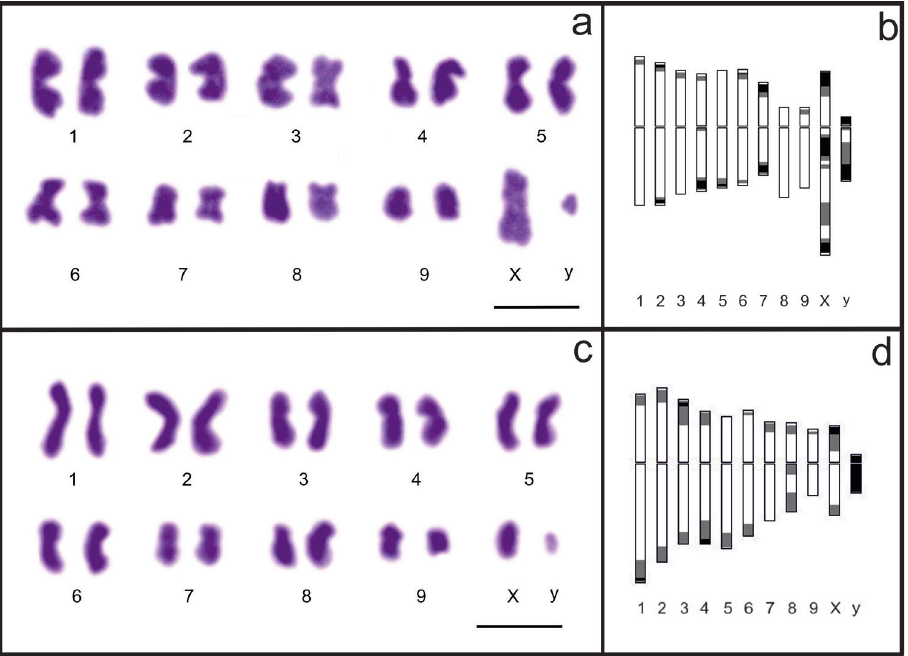
Figure 1. a–b N. bozdagus 2n = 20. a karyotype b idiogram c–d N. plebejus 2n = 20 c karyotype d idiogram. Bar = 5 Table 1. Chromosome morphologies and measurements of N. bozdagus and N. plebejus. CI: centromere index, RL: relative length, AR: arm ratio, *secondary constriction. N. bozdagus